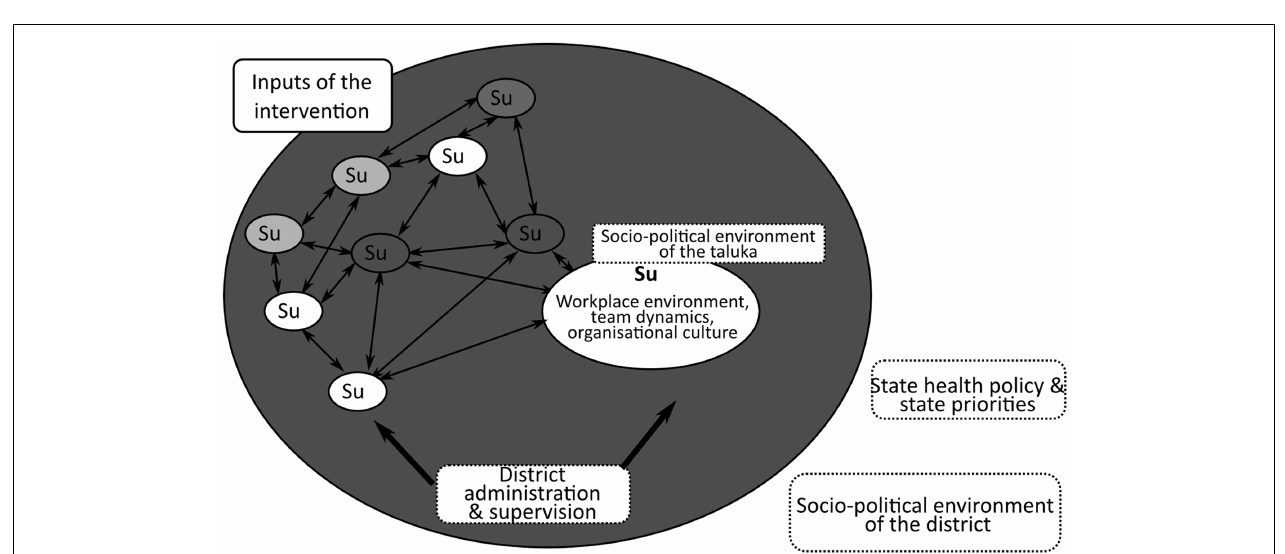
district level intervention interacts within and among the constituent local health systems in the district as well as the policy environment of the district